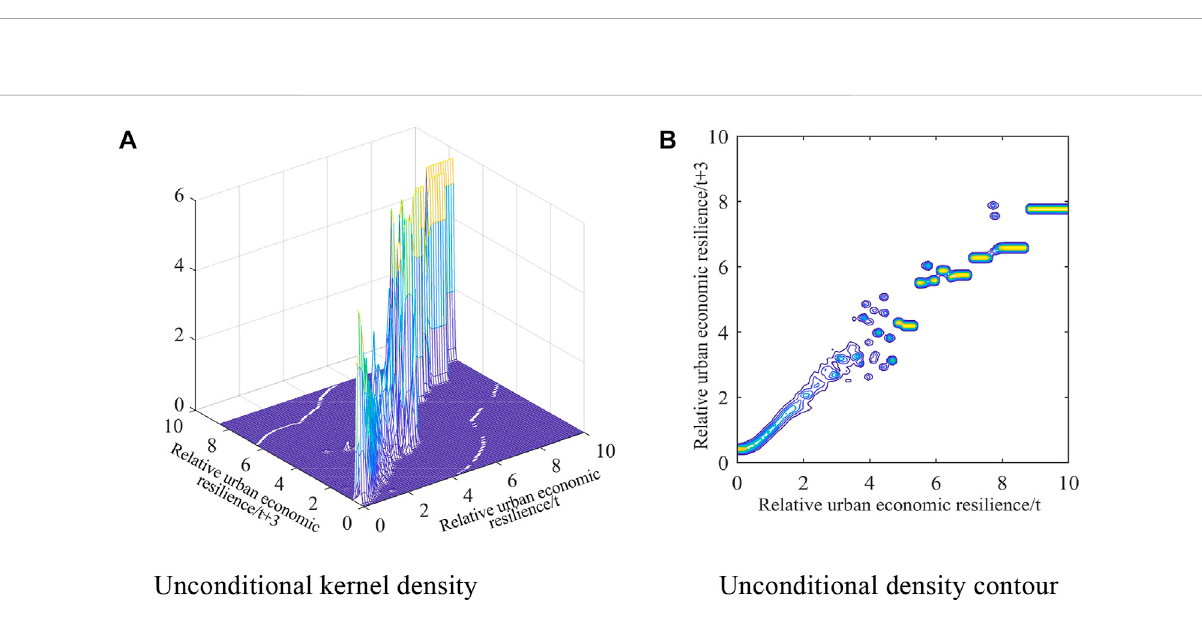
FIGURE 6 Unconditional kernel density of economic resilience in Chinese cities. (A) Unconditional kernel density. (B) Unconditional density